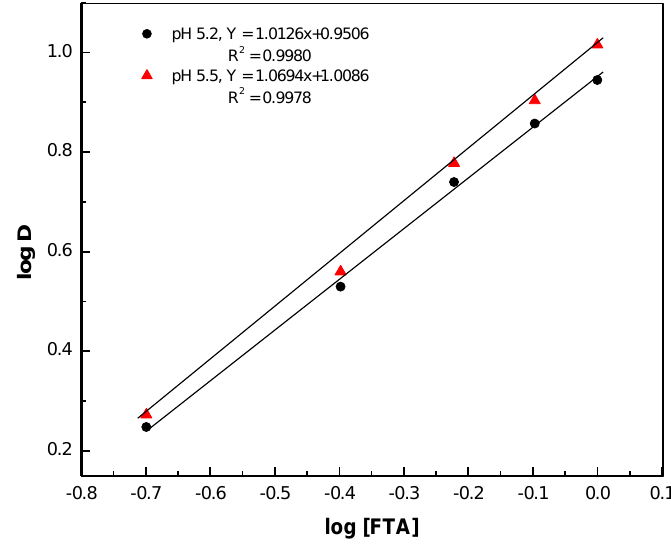
Fig. 4. Plot of log D vs log [FTA], (FTA= furfuryl